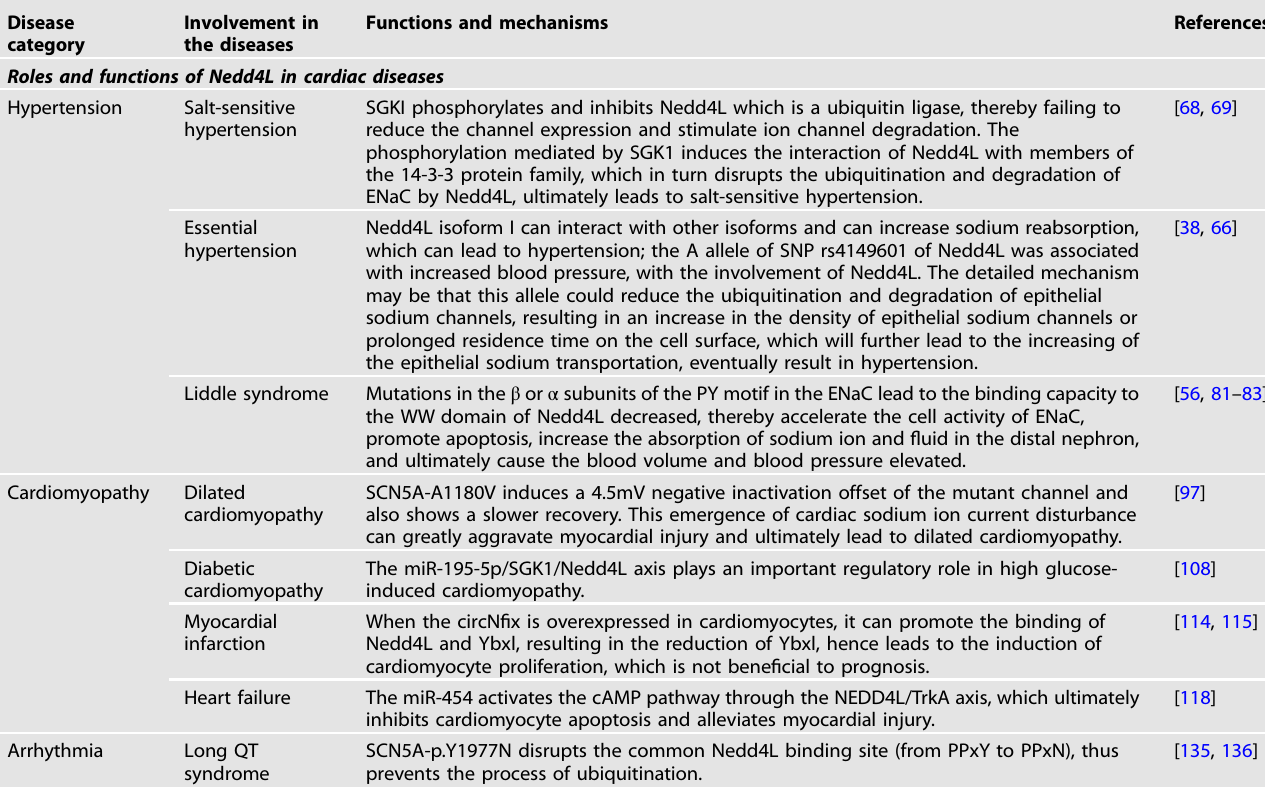
Table 2. This table shows the roles and functions of Nedd4L in various cardiac diseases, especially